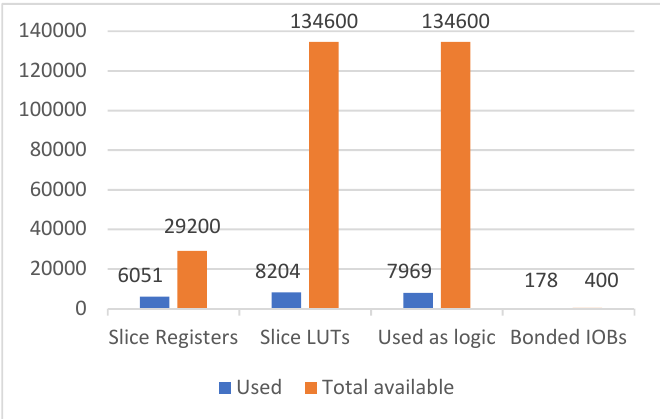
Figure 13. System architecture of FPGA implementation.